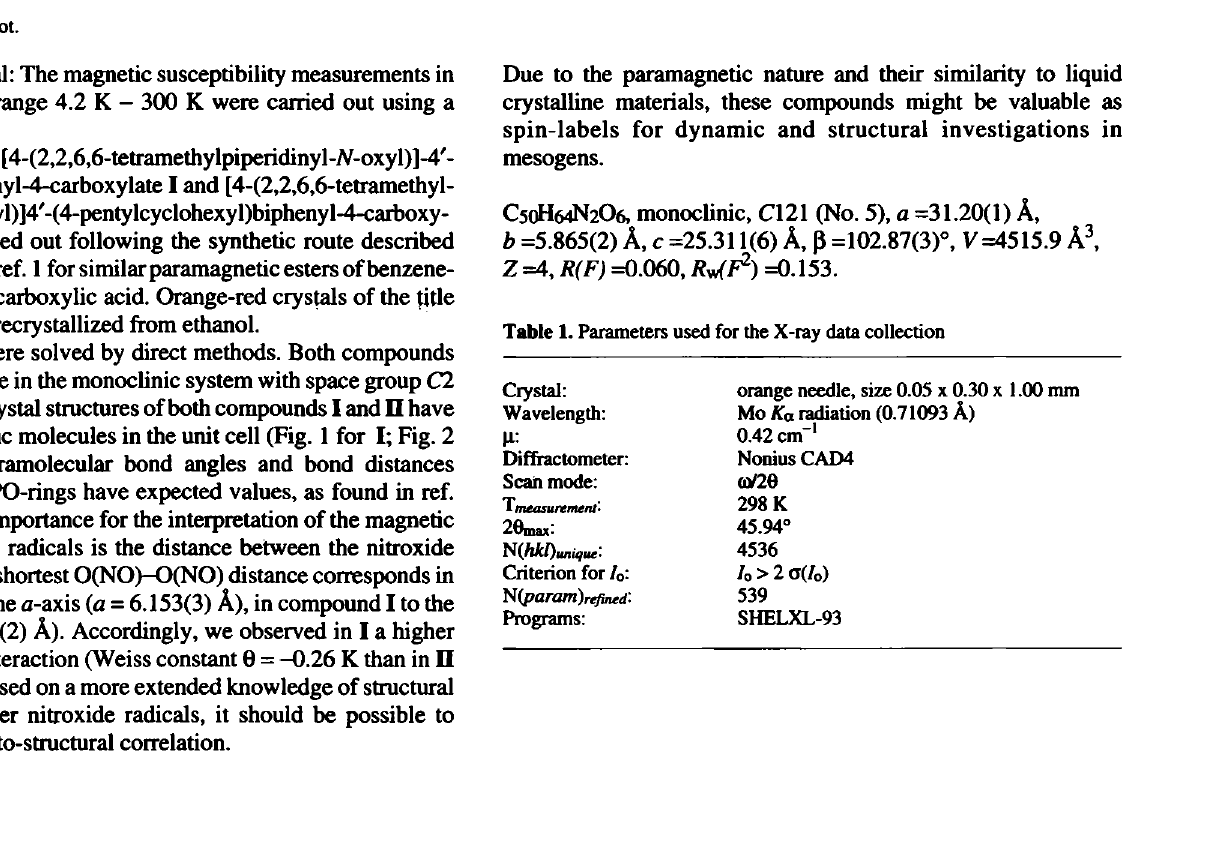
Fig.l. Molecule plot.